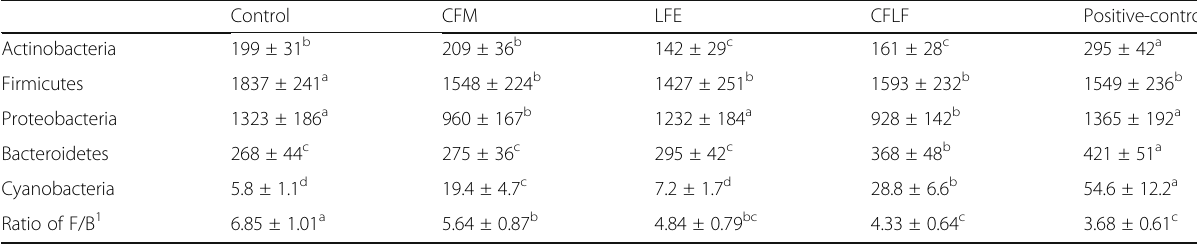
Table 4 Gut microbiomes (unit: counts)